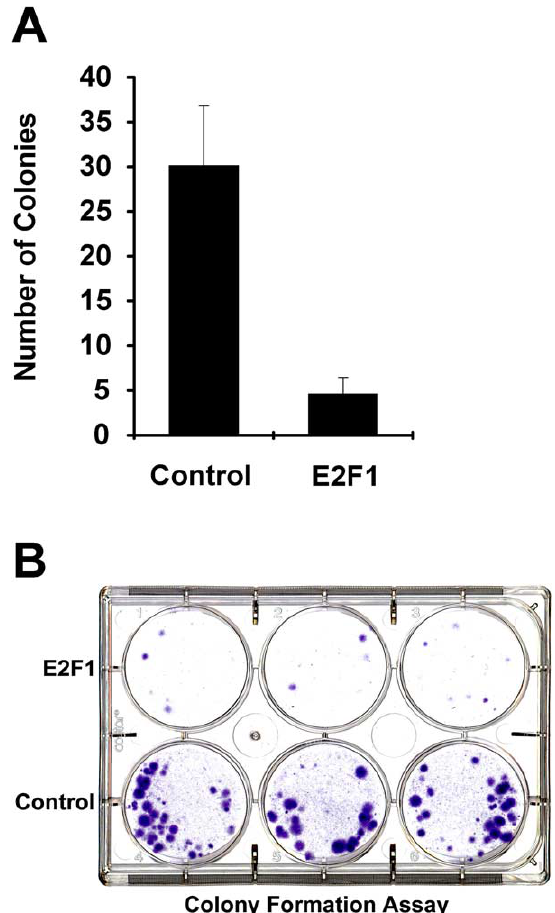
Fig. 6. Effect of E2F-1 overexpression on cell growth in cultured hu- man stomach cancer cells, as determined by the colony growth assay. (A) MKN-45 cells were plated in six-well plates, transiently trans- fected with either pCMV-E2F-1-HA or the empty vector pCMV-HA, and grown in G418 for 7 days. The surviving fraction of cells (visible colonies) was stained with gentian violet, photographed, and counted manually. Each column presents the mean ± SD from three separate determinations. P < 0 . 001 for control vs . E2F-1 group. (B) A repre- sentative result of the colony formation assay obtained from three in- dependent experiments. E2F1 , MKN-45 cells transiently transfected with pCMV-E2F-1-HA; Control , MKN-45 cells transiently trans- fected with